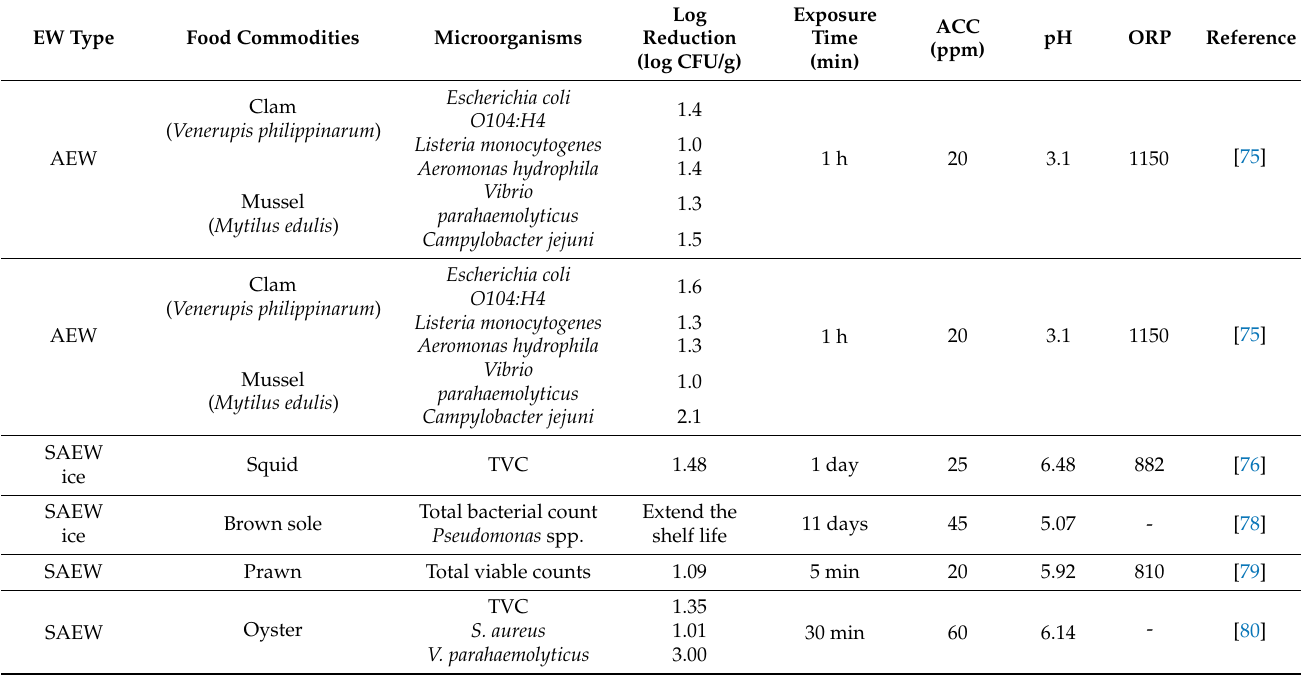
Table 3. Application of EW against various microorganism in aquatic